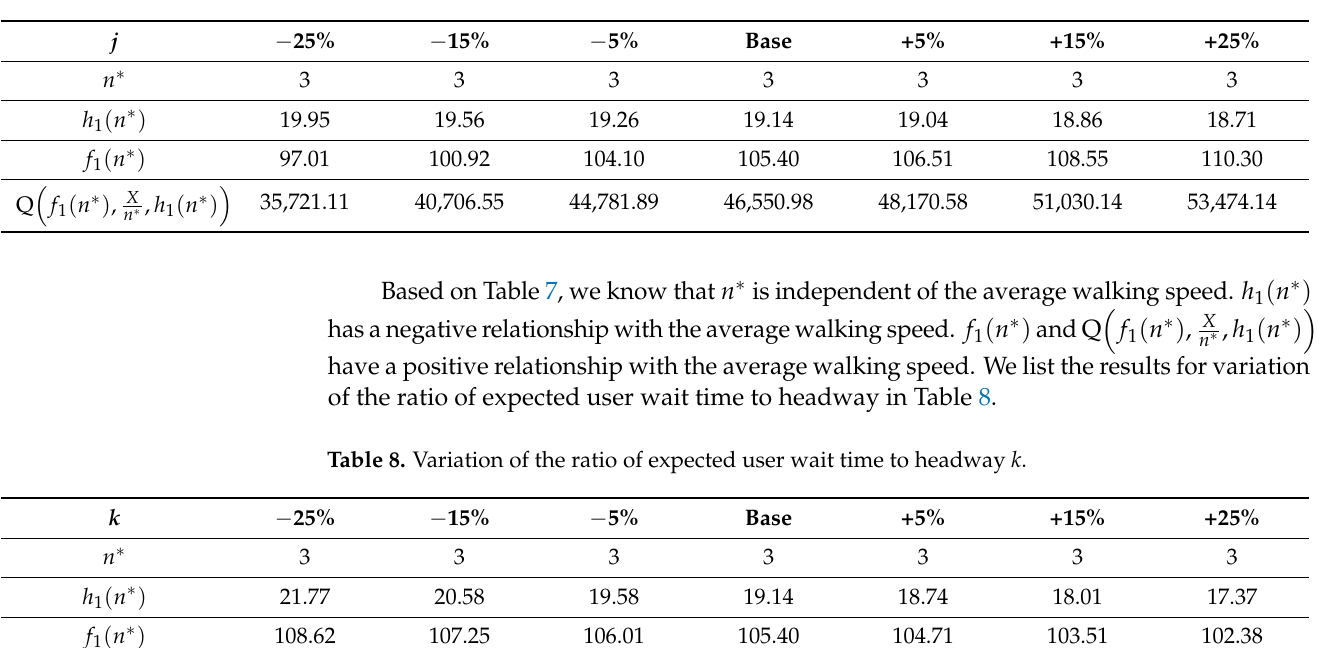
Table 7. Variation of the average walking speed j .